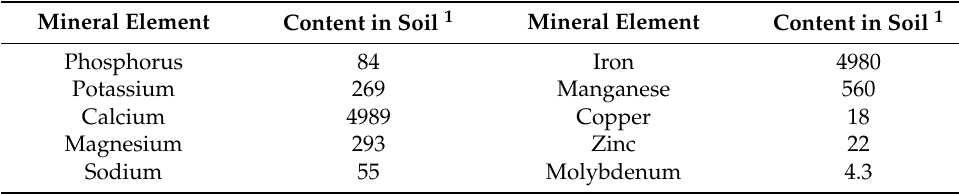
Table 1. Agrochemical characteristics of the soil. Mineral Element